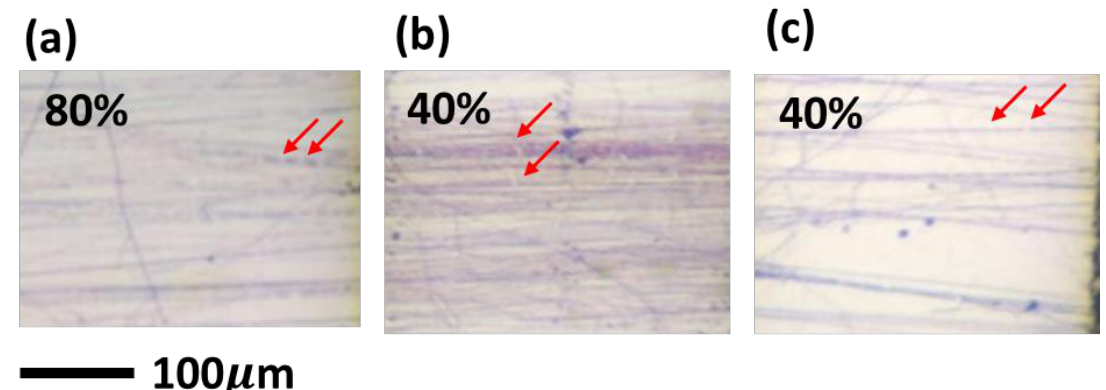
Figure 12. Ductility test of P3HT electrospun nanofibers prepared from ( a ) CF, ( b ) CB and ( c ) TCB systems. The red arrows indicate the crack formation.